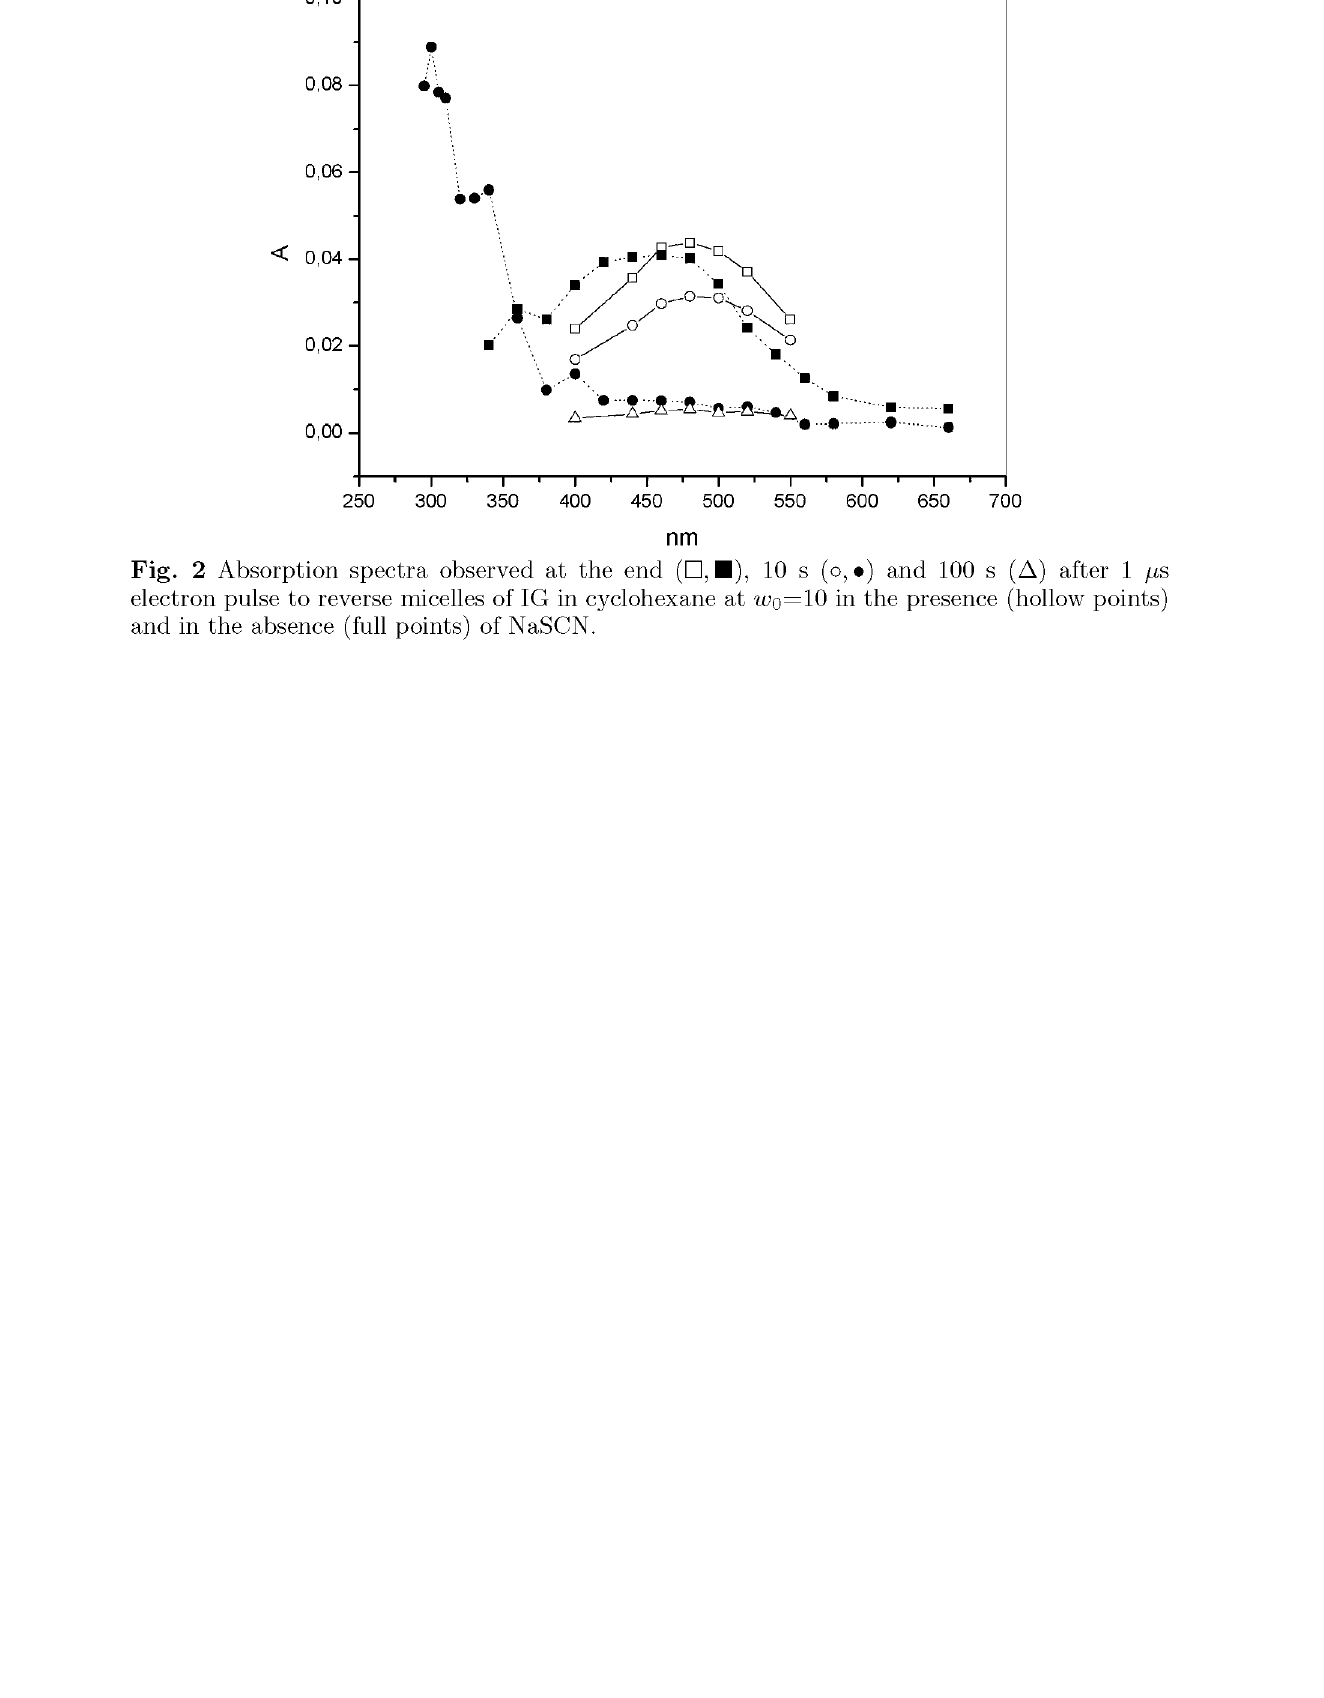
Fig. 2 Absorption spectra observed at the end (q,I), 10 s (%*) and 100 s (A) after 1 #s electron pulse to reverse nficelles of IG in cyclohexane at w0 10 in the presence (hollow points) and in the absence (full points) of